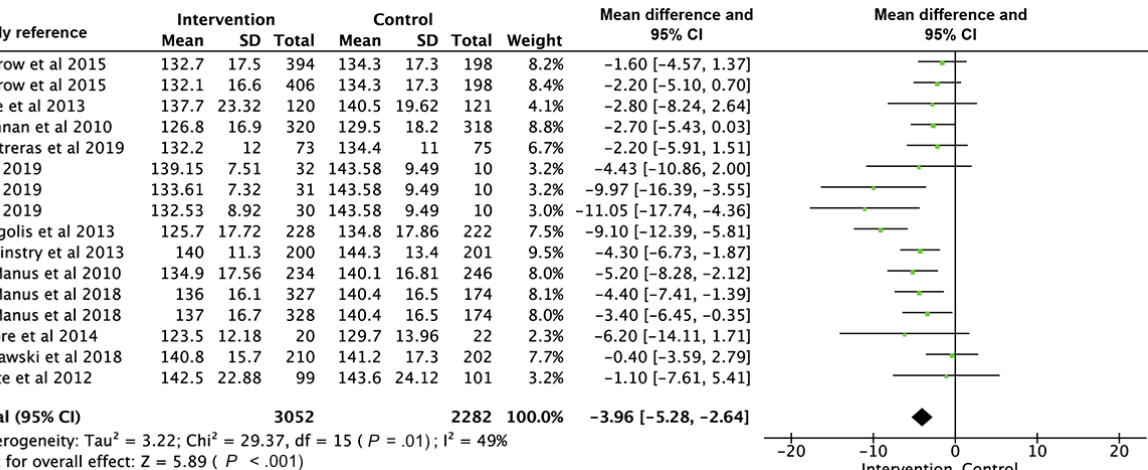
Figure 2. Forest plot of the difference of systolic blood pressure between intervention and control